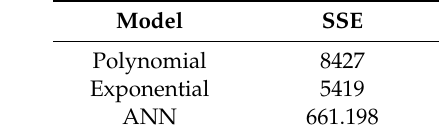
Table 4. Sum Square Error Results.